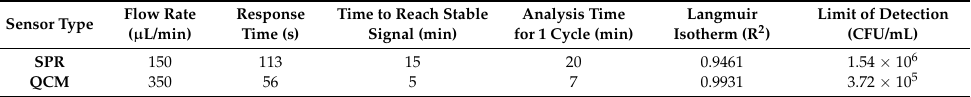
Table 1. Comparison of SPR and QCM sensors data for E. coli , the tested concentration range for